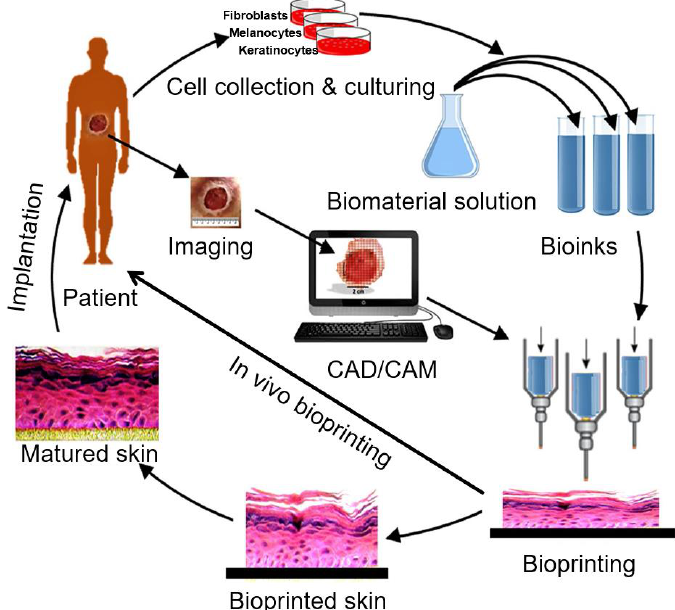
Figure 2. The basic process of 3D bioprinting skin. Various cells like keratinocytes, fibroblasts and melanocytes are collected from the patient and cultured in a cell culture system. A